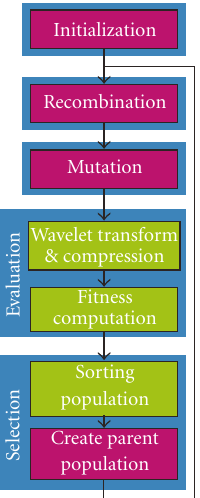
Figure 3: Flow graph of the